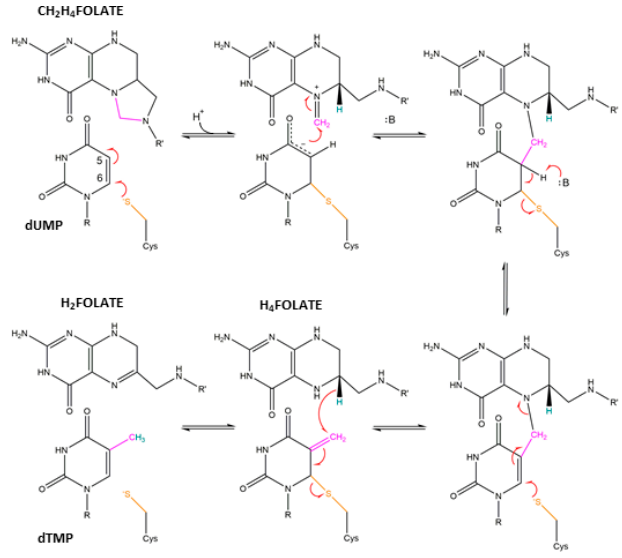
Scheme 1. Proposed reaction scheme for the TS catalyzed reaction. Adapted from [9,10].